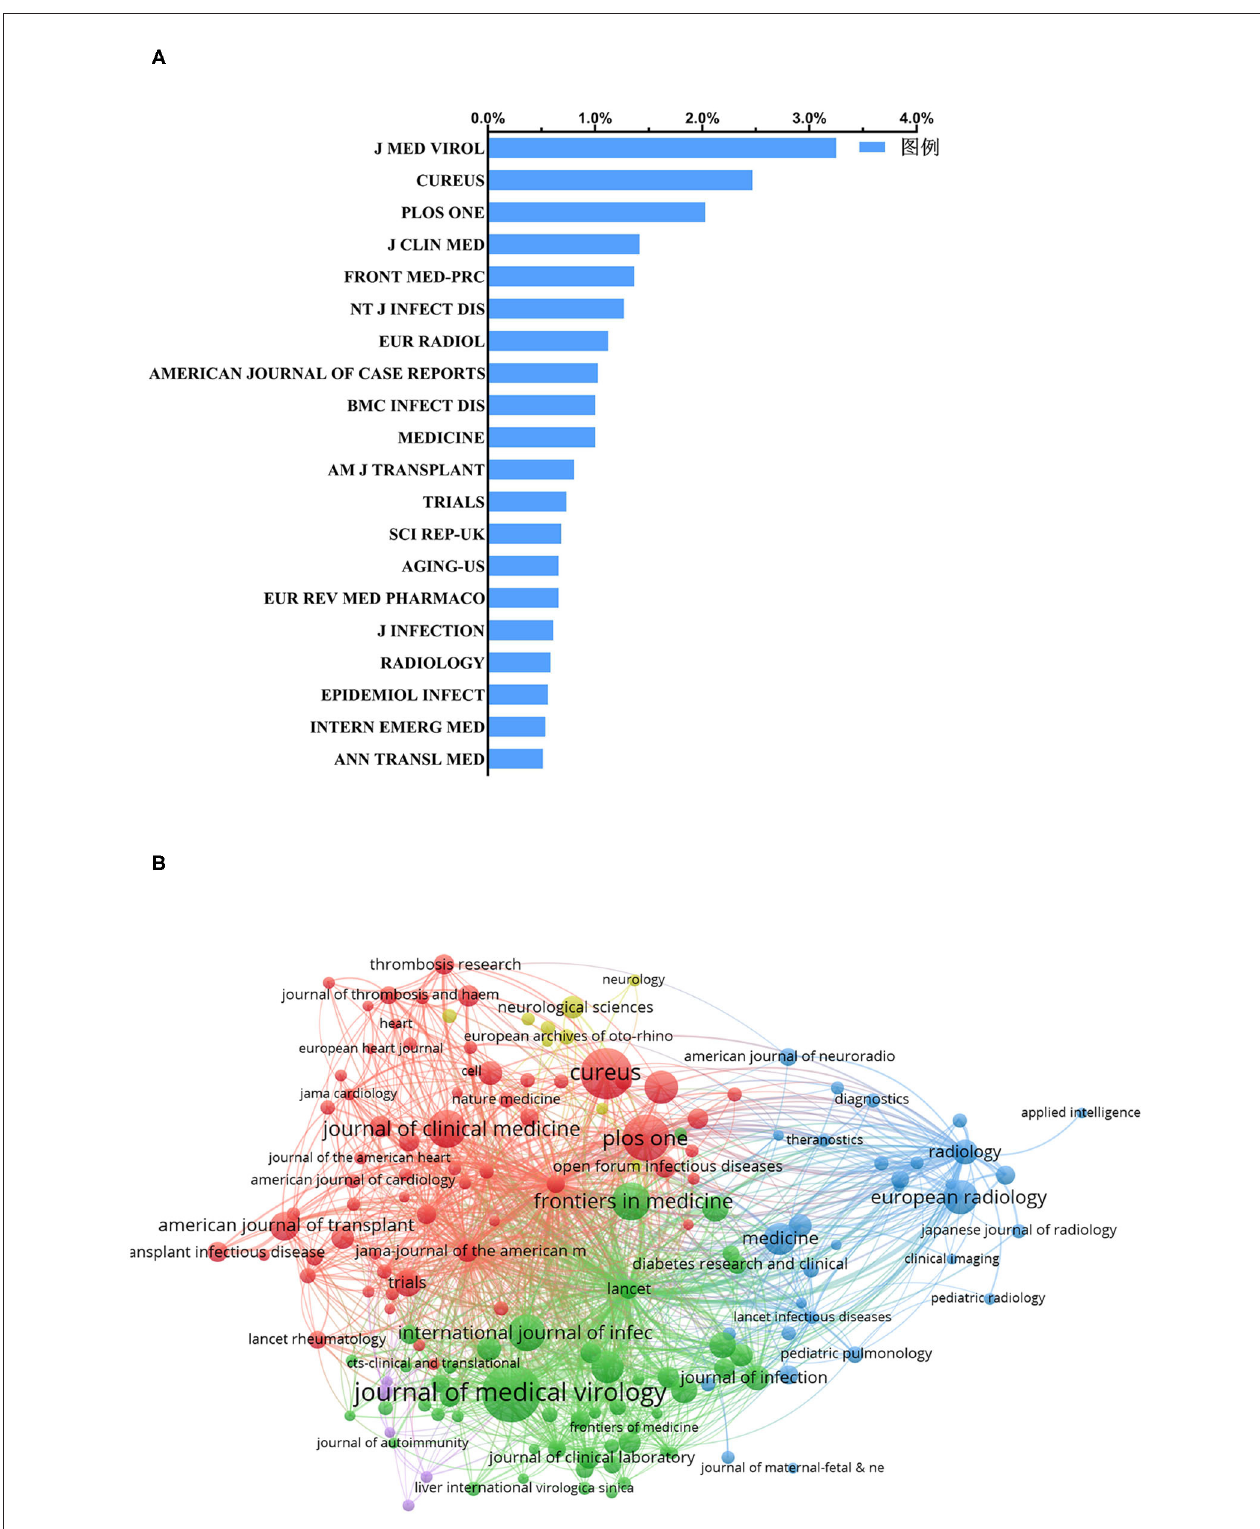
FIGURE 4 | Distribution of journals focused on COVID-19. (A) Distribution of the top 20 journals publishing the most clinical research studies on COVID-19. (B) Bibliometric analysis of citations by the journal. Different colors indicate different clusters, and the size of circles reveals the number of publications.